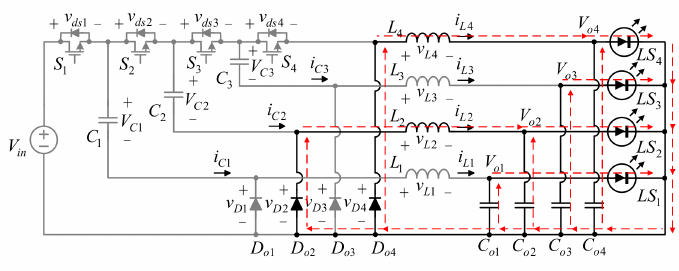
Figure 9. Current flow in state 6 in